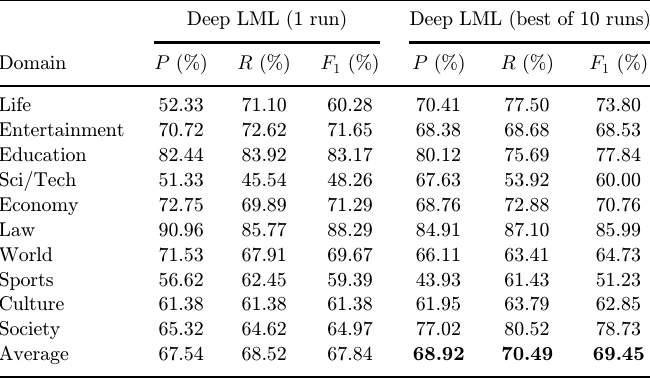
Table 6. Cross-domain results (the best of 10 runs).